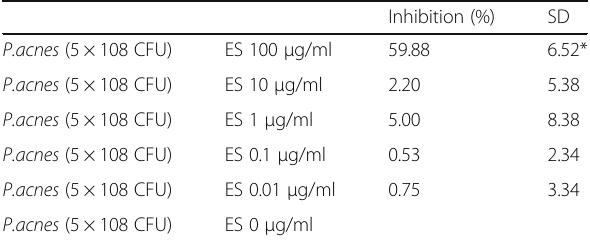
Table 1 The inhibitory effect of ES on lipase activity. P.acnes (5.0 × 108 cells/ ml) and 0.01 – .100 μ g/ml of ES were added to 96 well plates. 24 h later, 50 μ l of supernatants were mixed with 50 μ l of 4-MUO. 30 min later, 100 μ l of 0.1 M sodium citrate was added. Then lipase.activity was measured using fluorometric microplate reader. Values represent mean ± SD ( n =.4). Data were analyzed by Tukey post hoc test (* P < 0.05 versus P.acnes alone)